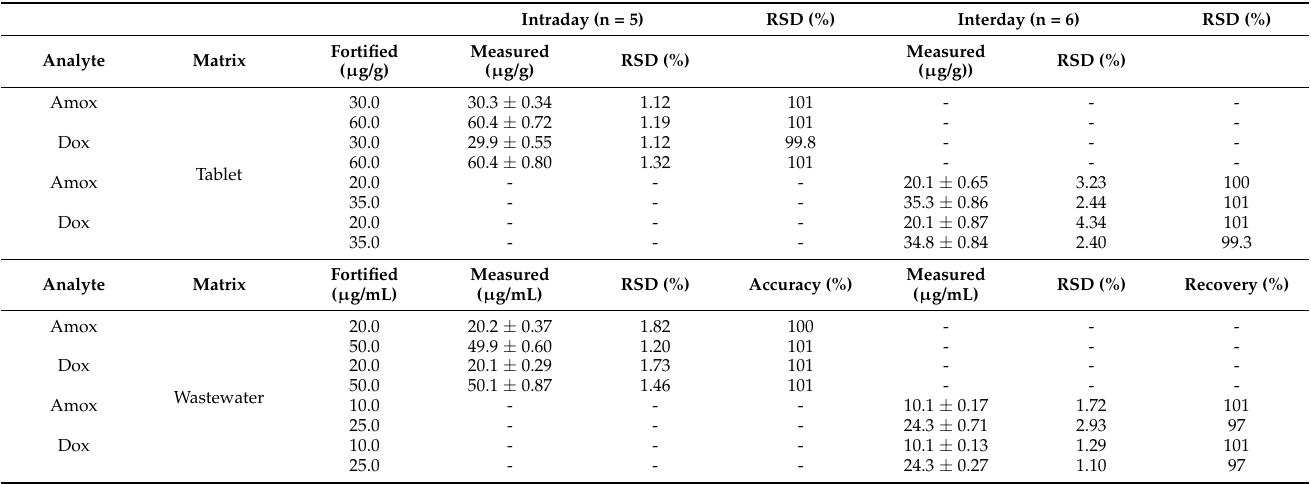
Table 4. Intraday and Interday Precision and Accuracy for Amox and Dox in Commercial Tablets